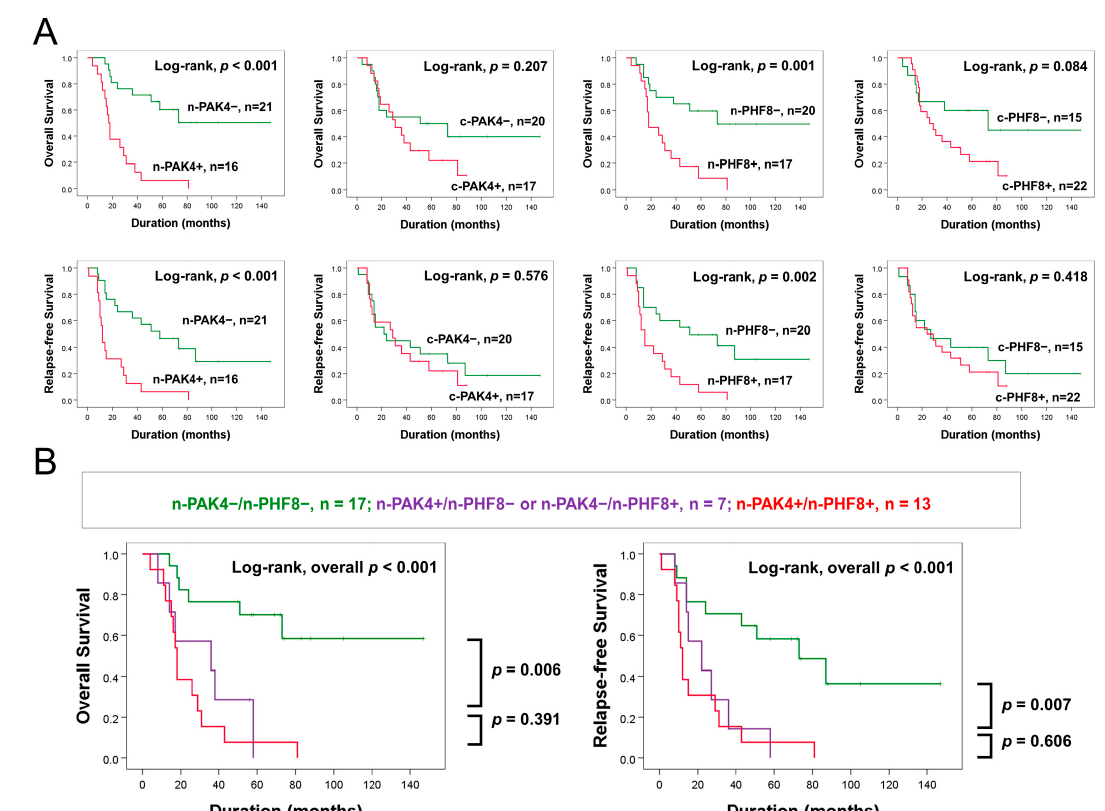
Figure 4. Survival analysis according to the individual and combined expression patterns of n-PAK4 and n-PHF8 in 37 patients who received postoperative therapy. ( A ) Kaplan–Meier survival